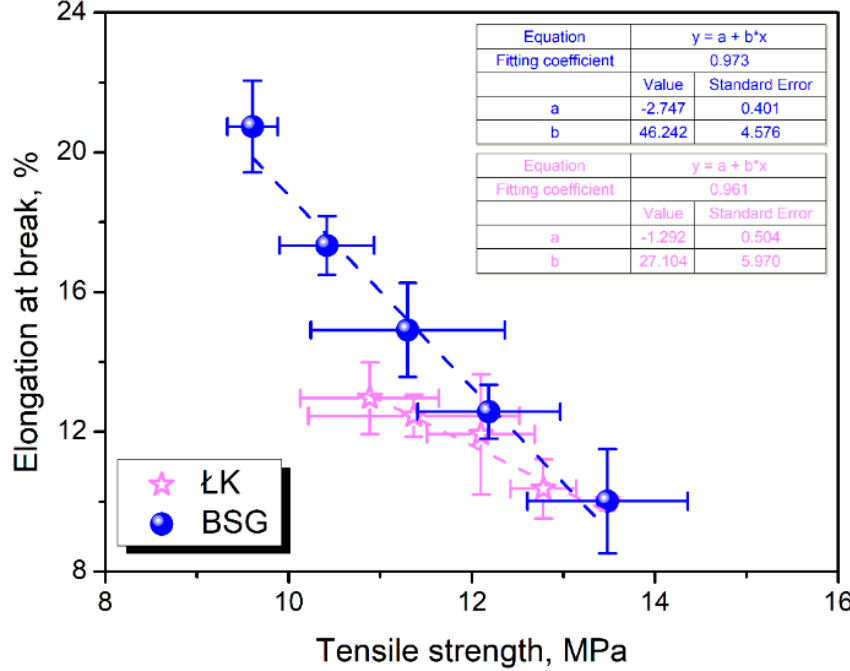
Figure 8. The dependence between tensile strength and elongation at break of prepared composites.